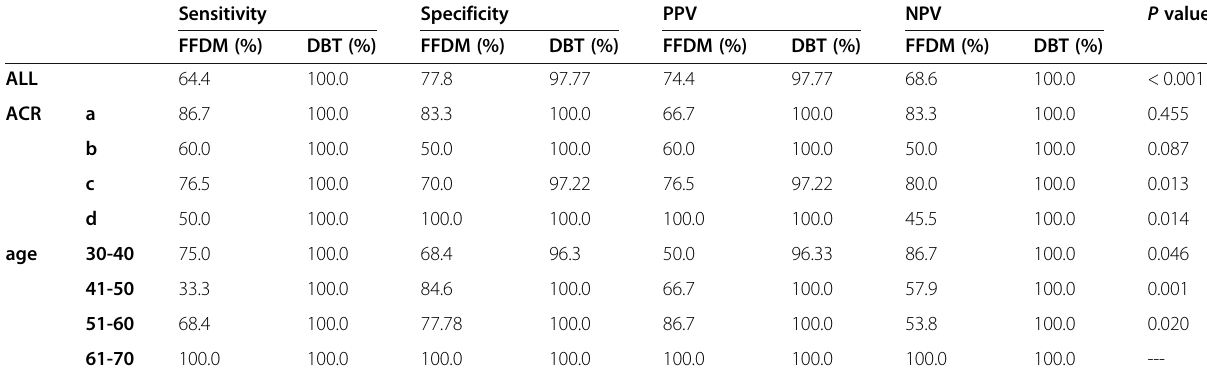
Table 4 Comparison of diagnostic indices of mammography and tomosynthesis in different breast densities and age groups (significant P value <